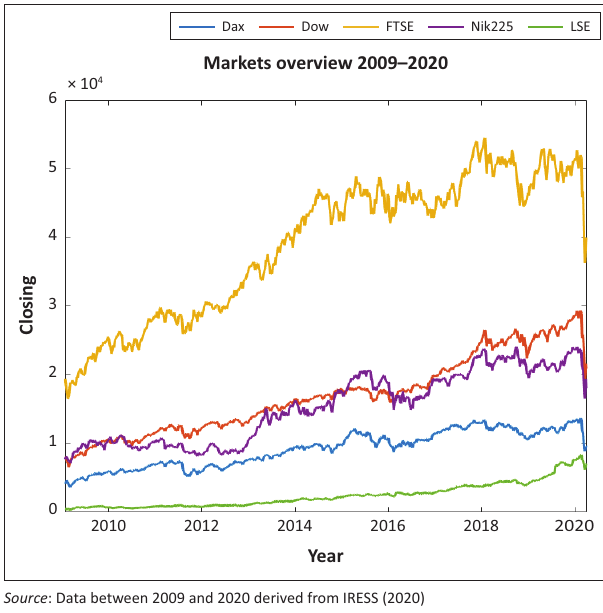
FIGURE 1: Graphical representation of the Dax, Dow Jones Industrial Average, Financial Times Stock Exchange/Johannesburg Stock Exchange All Share, Nikkei 225 and the London Stock